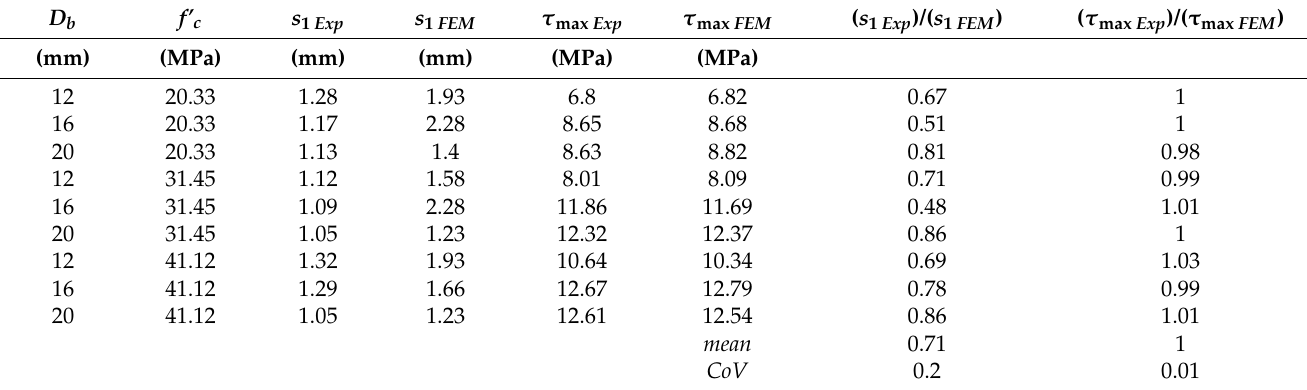
Figure 10. The bond stress-slip curves obtained from experiments, FEM models, and theoretical models. ( a ) Specimens in group GP1 with various rebars; ( b ) specimens in group GP2 with various rebars; ( c ) specimens in group GP3 with various rebars. Table 6. Comparison between test results and FEM